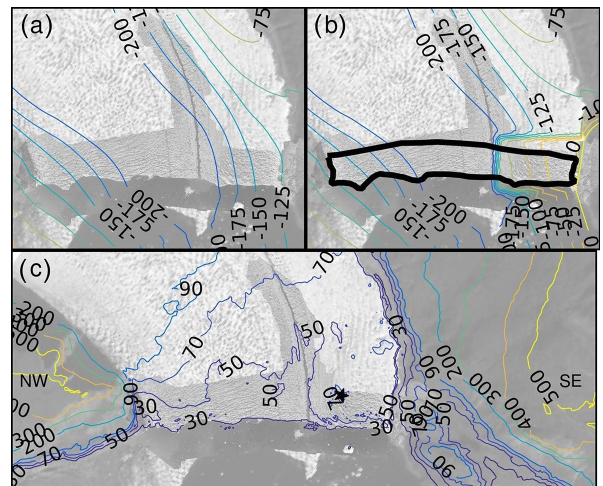
Figure 6. Contour lines of the initial bedrock topography (a) , the optimized bedrock topography (b) and the digital elevation model (c) in the neighbourhood of the calving front. The thick line in panel (b) indicates the reduced modelled domain in which the bedrock was optimized. Panel (c) reveals the presence of a 20m high bump (shown by the (cid:70) symbol) on the glacier surface and of a ridge on the south-eastern side of the